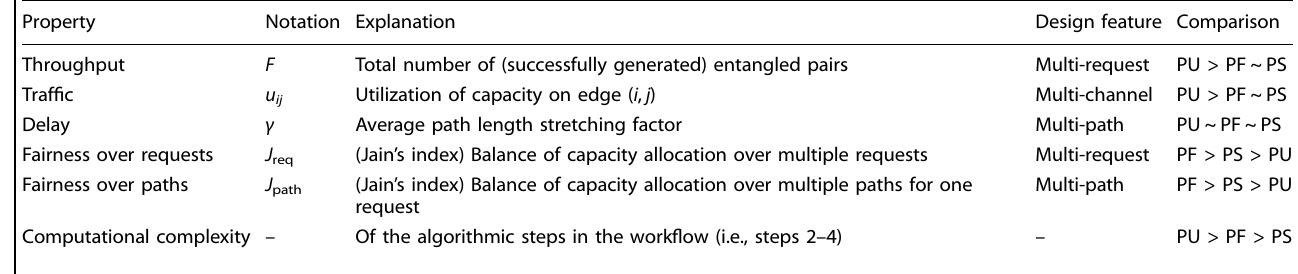
Table 1. Evaluation of routing